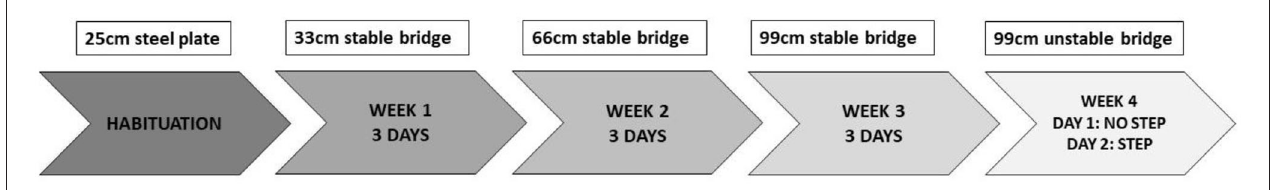
FIGURE 2 | The procedure was conducted 3 days per week for 4 weeks on Tuesday, Wednesday, and Thursday. Animals were food-deprived at homecage on Monday morning, and food was available ad libitum on Thursday evening. Initially, subjects underwent 2 days of habituation. They had a 25-cm steel plate to cross from “A” to “B.” During the 1st week, subjects performed on the 33-cm bridge. During the 2nd week, subjects performed on the 66-cm bridge. During the 3rd week, subjects performed on the 99-cm stable bridge. During the 4th week, subjects performed on the 99-cm unstable bridge. In the latter case, during the 2nd day of exposure, we added a space between the bridge and the arrival point to increase the subjects’ perception of danger. Moreover, in this way, the bridge swung more during the last “step”.